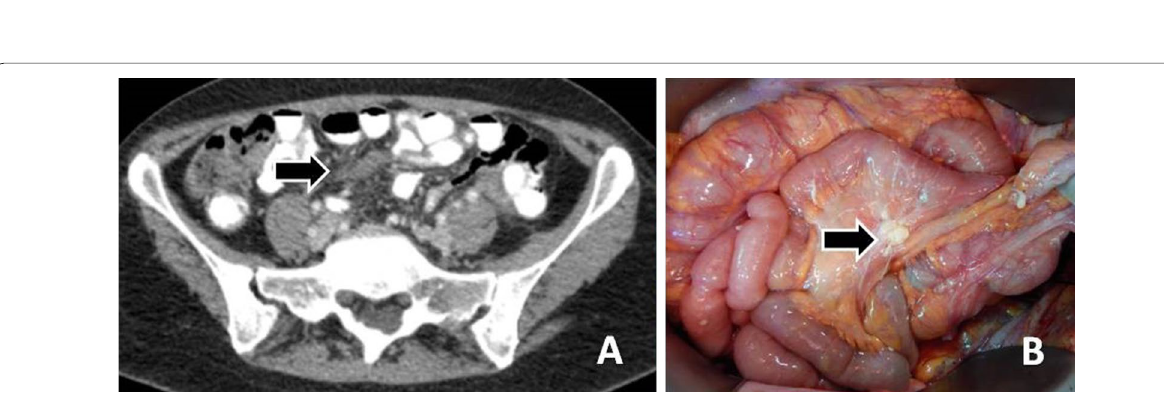
Fig. 14 a Contrast-enhanced CT image shows soft tissue density lesion in the mesentery (arrow). b The peritoneal implant confirmed at surgery